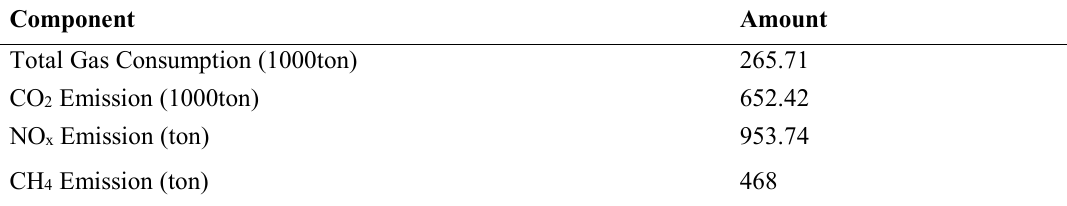
Table 9 : Annual natural gas consumption and emissions of Polkalleh CS at current condition